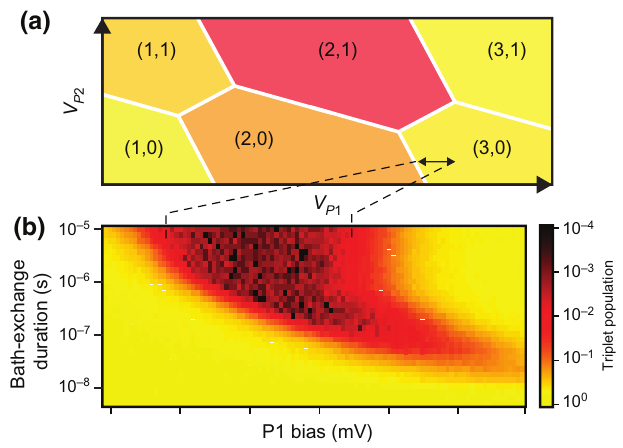
FIG. 6. A sweep of initialization bias and schematic of the initialization process. (a) The charge-stability diagram in the bias region relevant for initialization, showing the ground-state charge occupancy (color) as a function of bias. In this por- tion of the work, we initialize at the (2,0)-(3,0) boundary. (b) The sweeping of the P1 plunger gate bias across the (2,0)-(3,0) boundary and the sweeping time. This population is the thresh- olded result of a spin-state measurement immediately after bath exchange following preparation of a dephased state. The pop- ulations are not monotonic in duration, which is indicative of the bias waveforms settling in time. While our high-speed adder circuit (Appendix A) attempts to provide a flat response, not all nonidealities are accounted for. This settling limits the mini- mum initialization time in this case to roughly 300 ns to reach an asymptotic population of 6 × 10 − 4 . P1 biases differ from Fig. 5(a) because additional (pulsed) tunnel-barrier bias is introduced and the “T” gate has a nontrivial cross-capacitance to the first dot potential. This result is degraded from the Boltzmann distribution prediction for initialization fidelity alone (Eq. (3), approximately 5 × 10 − 4 ), due to measurement and mapping